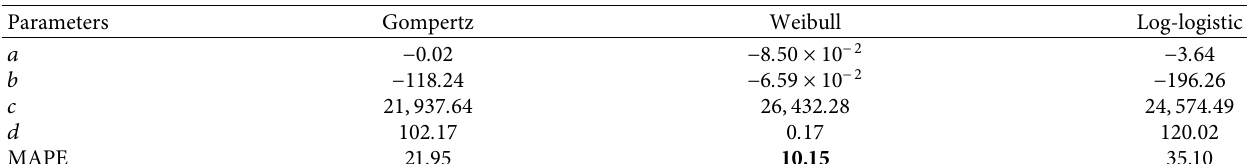
Figure 10: Fit of the frst derivative of the Weibull curve (in red) to the number of daily infections (in blue) by COVID-19 in Chile (using data from March 2 to October 31, 2020). Table 2: Values of the estimated parameters for the three growth models studied when ftting the number of accumulated deaths by COVID- 19 in Chile. Te last row contains the MAPEs for the various fts.